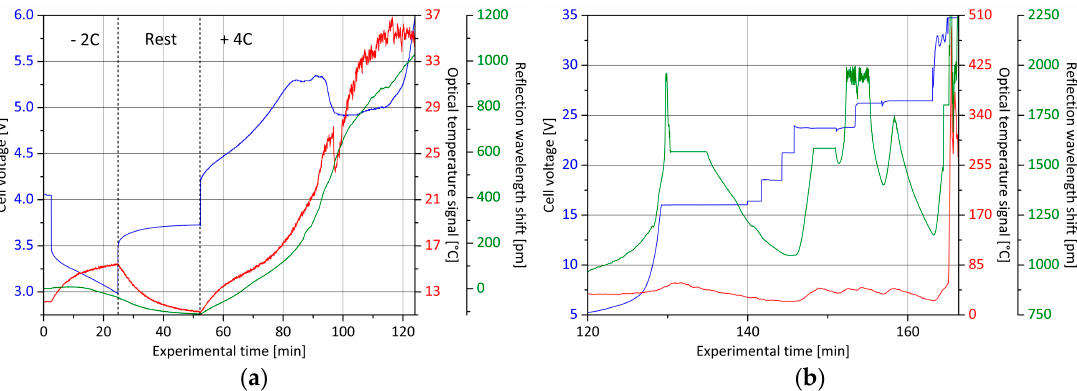
Figure 5. Overcharge experiment with the core Bragg grating integrated lithium ion battery cell: ( a ) After a discharge and resting period, the cell is charged with 4C and monitored in terms of cell voltage (blue curve), external temperature (red curve) and internal status (green curve); ( b ) during the second section, the cell is electrically forced to go into thermal runaway. The maximum charge voltage level has to be occasionally increased.